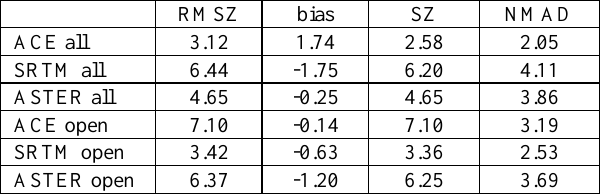
Table 1: accuracy in relation to reference data – for the whole